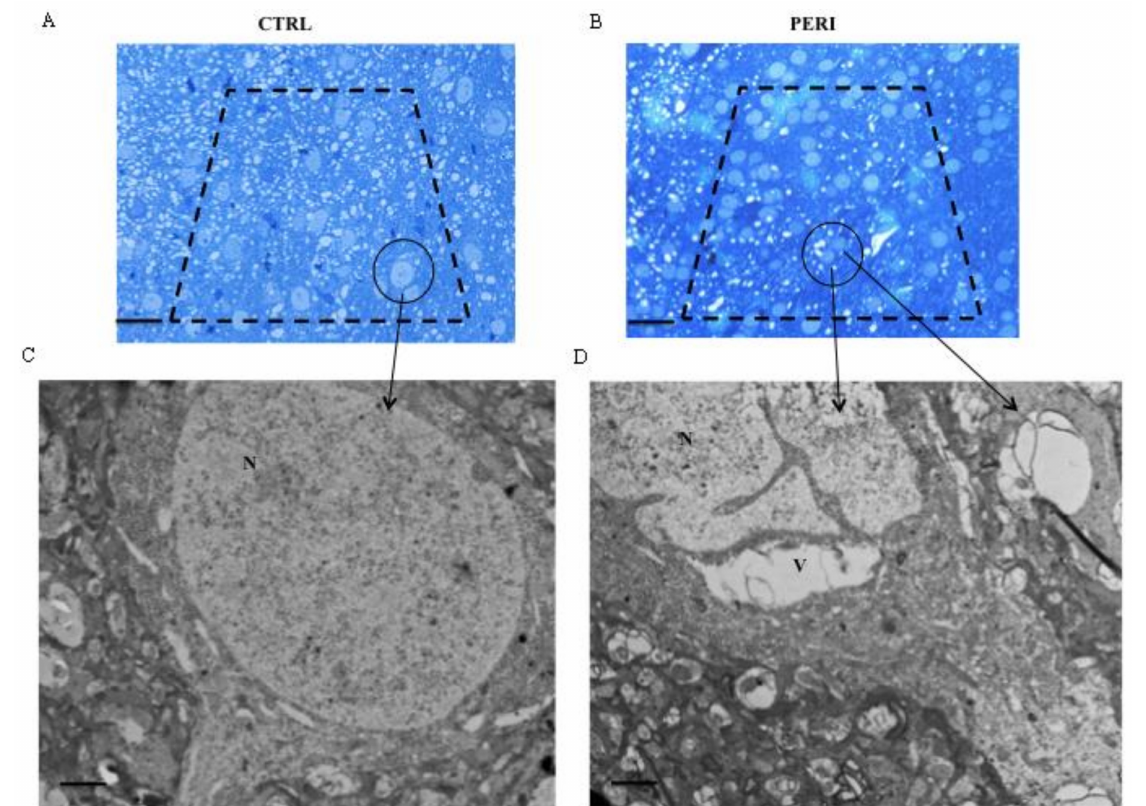
Figure 4. Representative pictures of contralateral cortex and penumbra area from an ischemic mouse. Semi-thin sections stained with toluidine blue from control cortex ( A ) and the penumbra cortical area ( B ) from an ischemic mouse. The dashed line indicates the area used for ultrathin section. In both representative semi-thin sections, the circle surrounds the neurons analyzed at TEM and reported in the corresponding panels ( C , D ). Scale bar = 60 µ m ( A , B ), 0.3 µ m ( C , D ). N = nucleus, V =